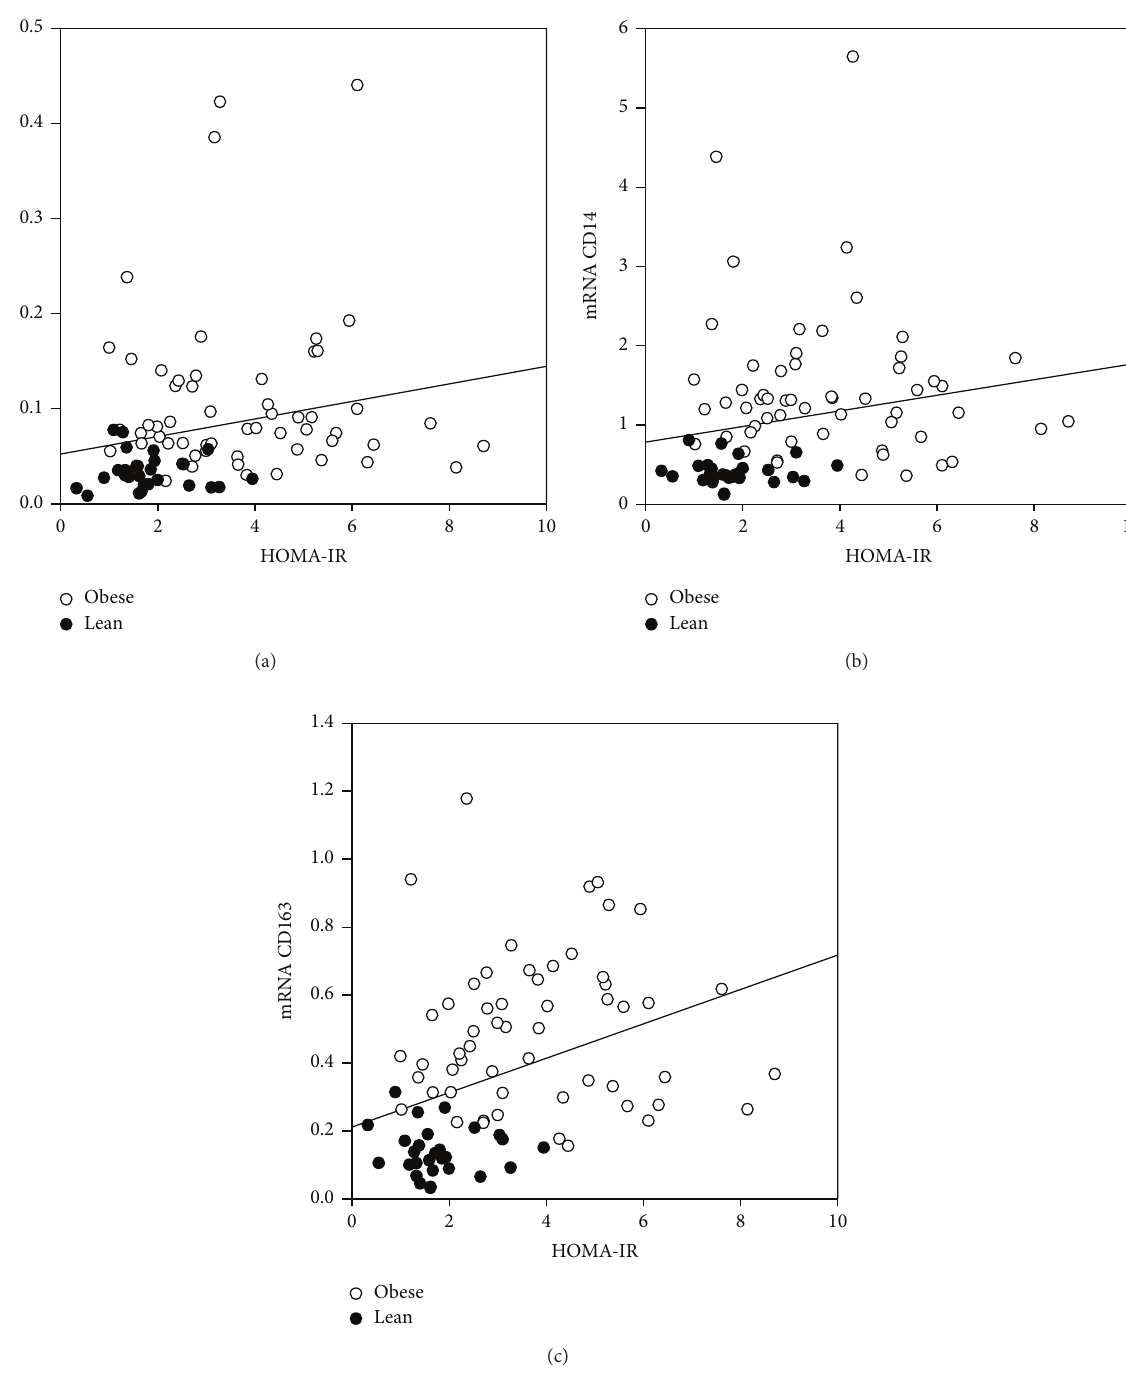
Figure 3: Association between the expression of CD68, CD14, and CD163 and HOMA-IR. Subcutaneous AT samples from lean and obese subjects ( 𝑛 = 92 ). Gene-expression levels of mRNA CD68, CD14, and CD163 measured by RT-PCR. HOMA-IR measured by fasting blood samples. Spearman’s correlation with 𝑟 = correlation coefficient. (a) Association between mRNA CD68 and HOMA-IR ( 𝑟 : 0.34, 𝑃 < 0.05 ), (b) association between mRNA CD14 and HOMA-IR ( 𝑟 : 0.37, 𝑃 < 0.001 ), and (c) association between mRNA CD163 and HOMA-IR ( 𝑟 : 0.47, 𝑃 < 0.001